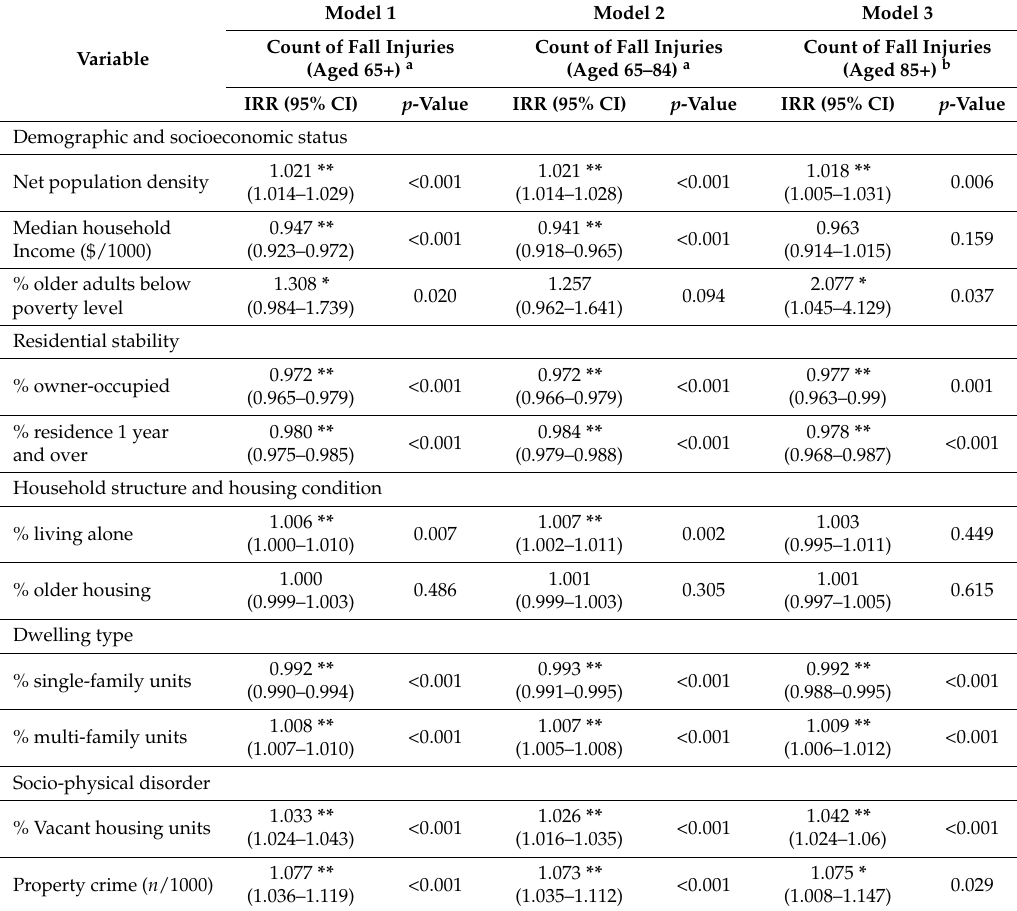
Table 3. Partially adjusted analysis: Neighborhood context and count of fall-related injuries at the census tract level ( n =